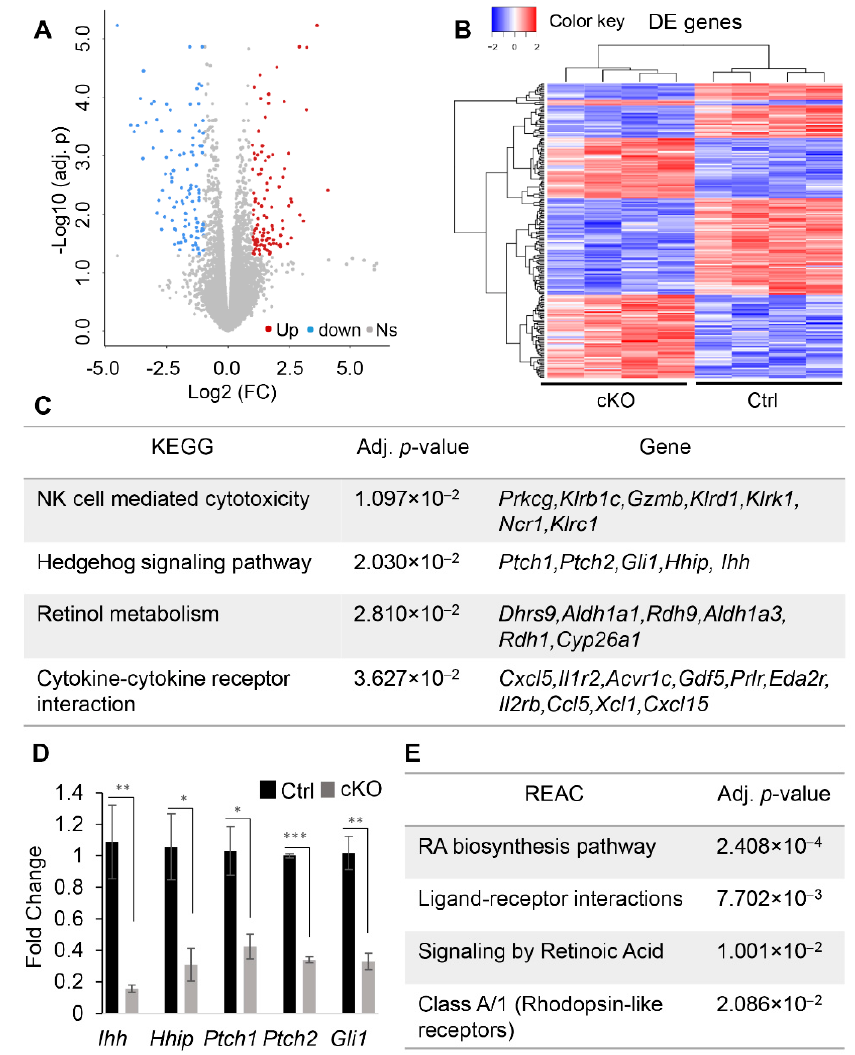
Figure 4. Transcriptomic profiling using RNA-seq to identify molecular changes in Ezh2 conditionally deleted uteri. ( A ) Volcano plot for genes identified by RNA-seq using uteri from control and Ezh2 Amhr2 -Cre cKO mice at PD10. Ns, not significant. ( B ) Heatmap depicting uterine DE genes between control and Ezh2 Amhr2 -Cre cKO mice at PD10. ( C ) Significantly enriched pathways in the uteri of Ezh2 Amhr2 -Cre cKO mice identified by g:Profiler tool using KEGG database. ( D ) Validation of DE genes related to hedgehog signaling using uteri from Ezh2 Amhr2 -Cre cKO mice and controls at PD10. n = 4. Data are mean ± s.e.m. * p < 0.05, ** p < 0.01, and *** p < 0.001. ( E ) Significantly enriched pathways in the uteri of Ezh2 Amhr2 ‐ Cre cKO mice identified by g:Profiler analysis using REAC database.